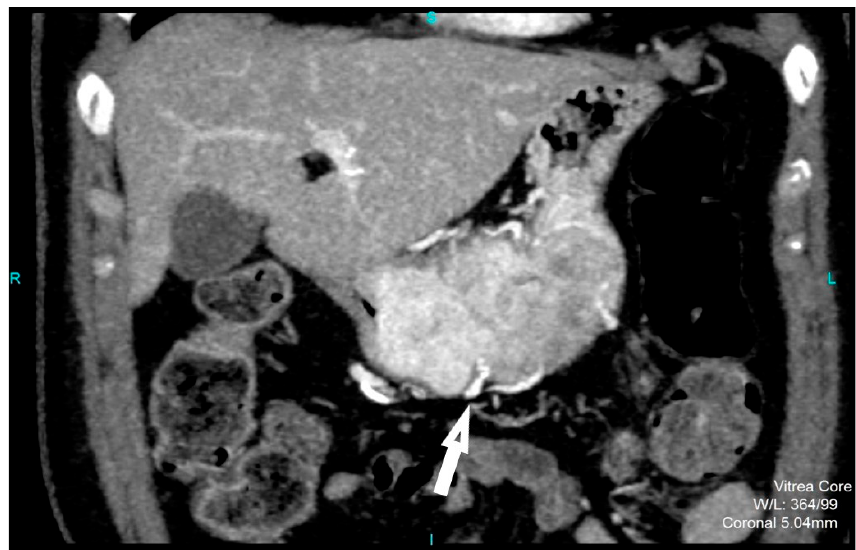
Figure 3. Contrast enhanced CT exam, coronal view, in a 49-year old female patient shows irregular shape and EFDV (white arrow) of a HR GIST.